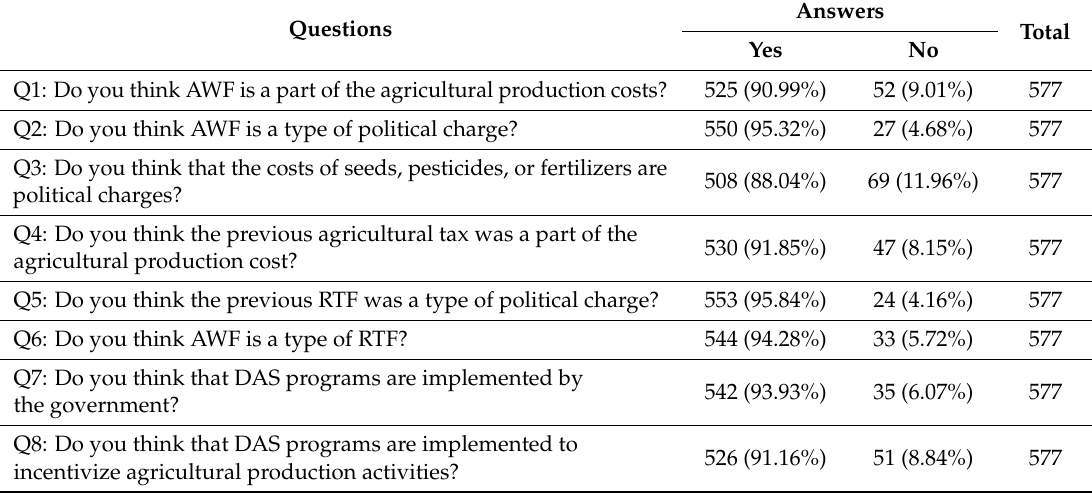
Table 4. Questions addressing farmers’ perceptions of the salient representativeness of AWF, RTF and